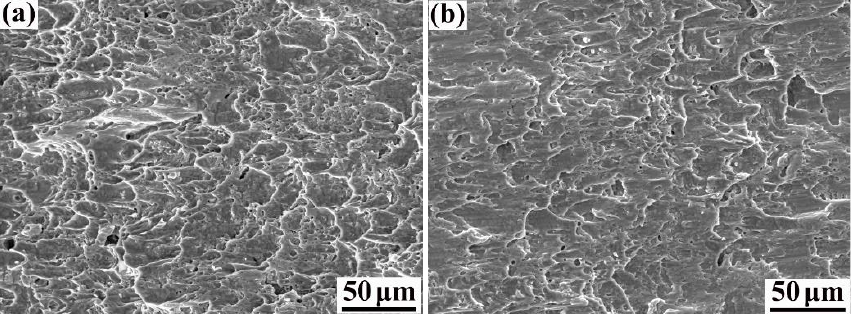
Figure 10. Shear fracture morphology of rebar: ( a ) carbon-steel side and ( b ) stainless-steel side.